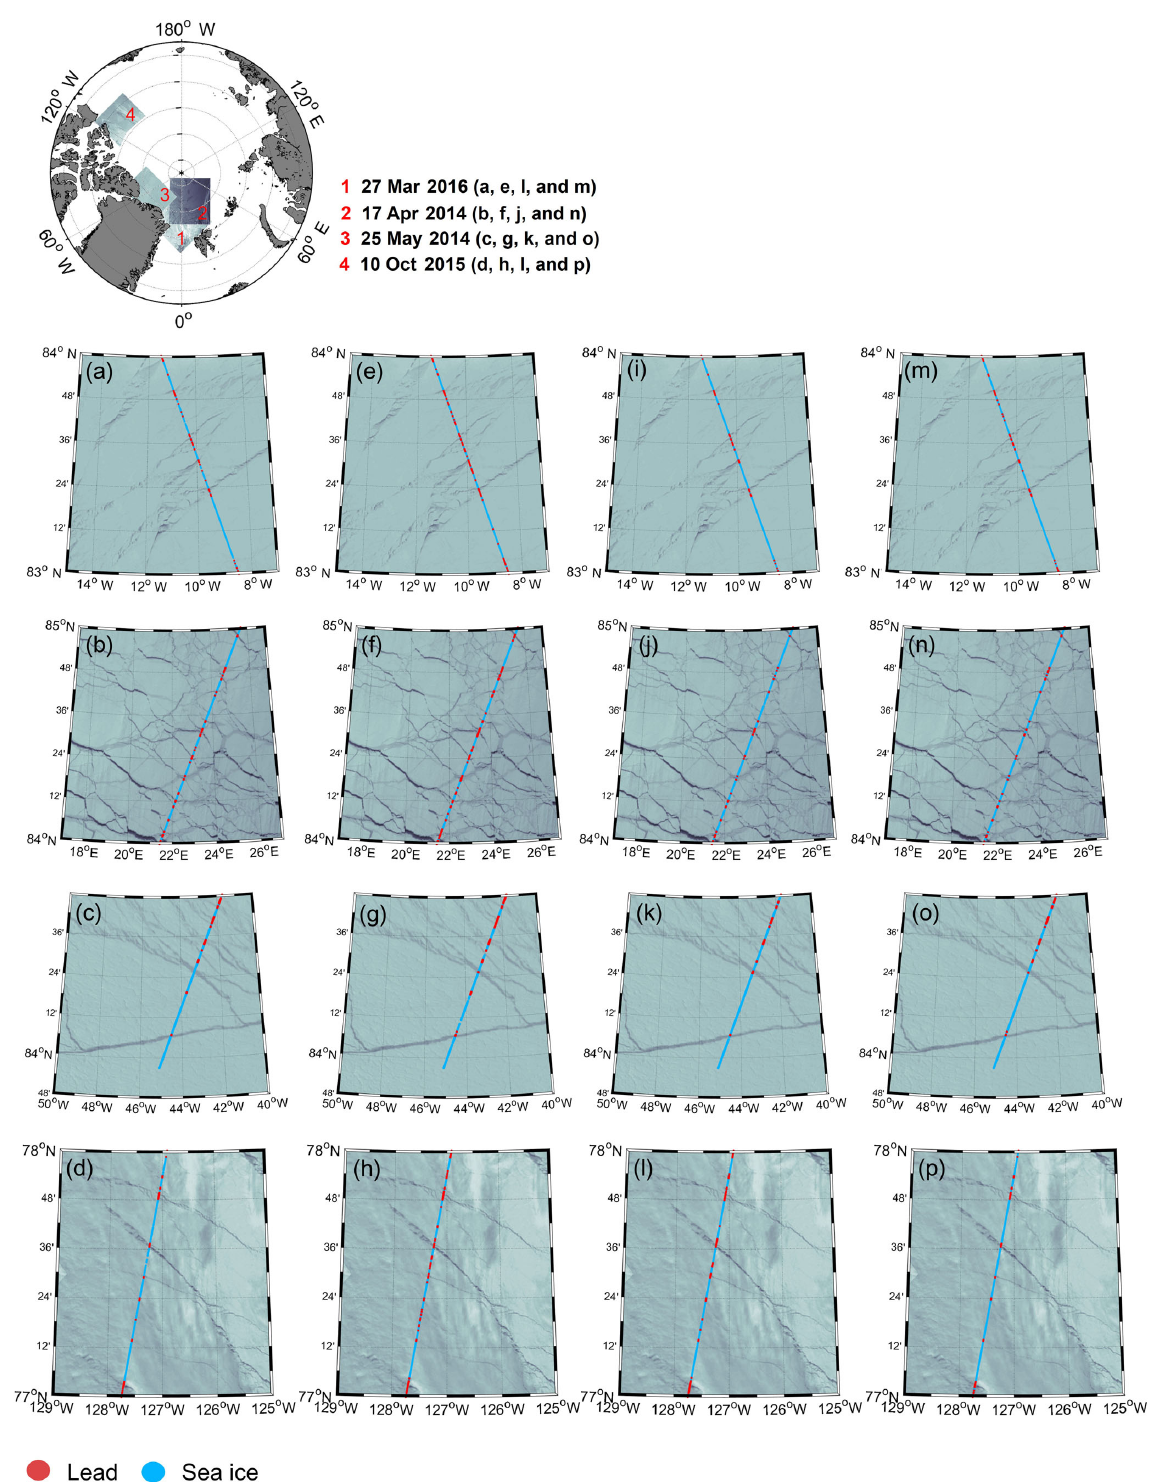
Figure 4. Visual comparison of lead classifications (a) – (d) based on Rose et al. (2013), (e) – (h) based on Laxon et al. (2013), (i) – (l) based on decision trees from Lee et al. (2016), and (m) – (p) based on the proposed waveform mixture algorithm. The MODIS data were collected on 27 March 2016 (a, e, i, m) , 17 April 2014 (b, f, j, n) , 25 May 2015 (c, g, k, o) , and 10 October 2015 (d, h, l, p) . An overview map of the location of cropped MODIS images is at the top of the